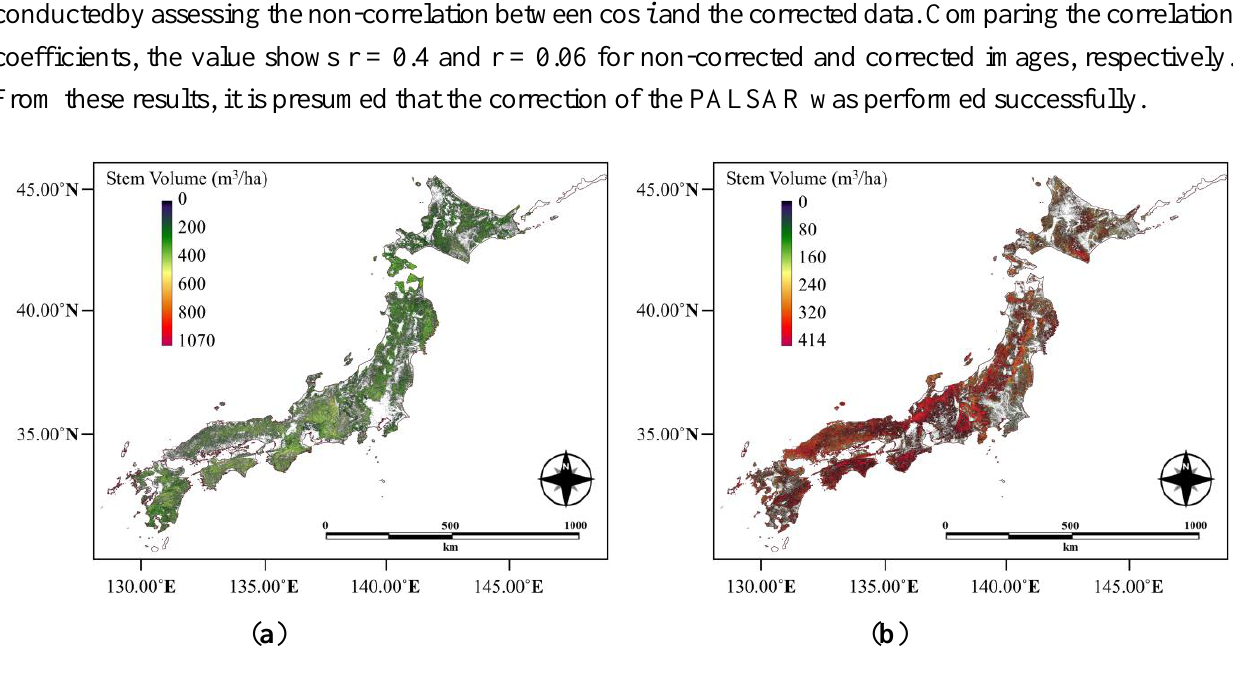
Figure 6. Stem volume map of Japan for the ( a ) coniferous forests and ( b ) deciduous and evergreen broadleaf forests. Forest cover data were overlaid with the stem volume map to extract only the forest types needed for each stem volume